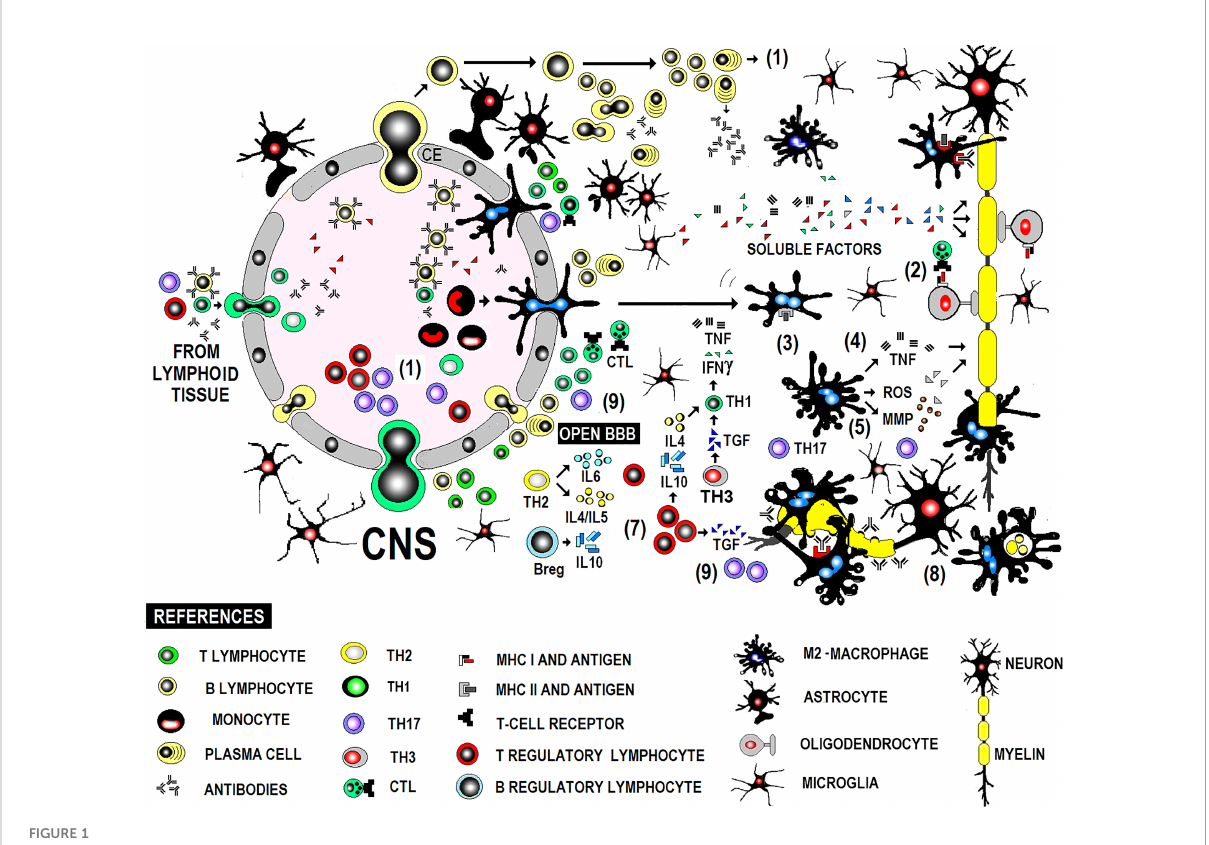
FIGURE 1 Immunopathogenesis of MS in